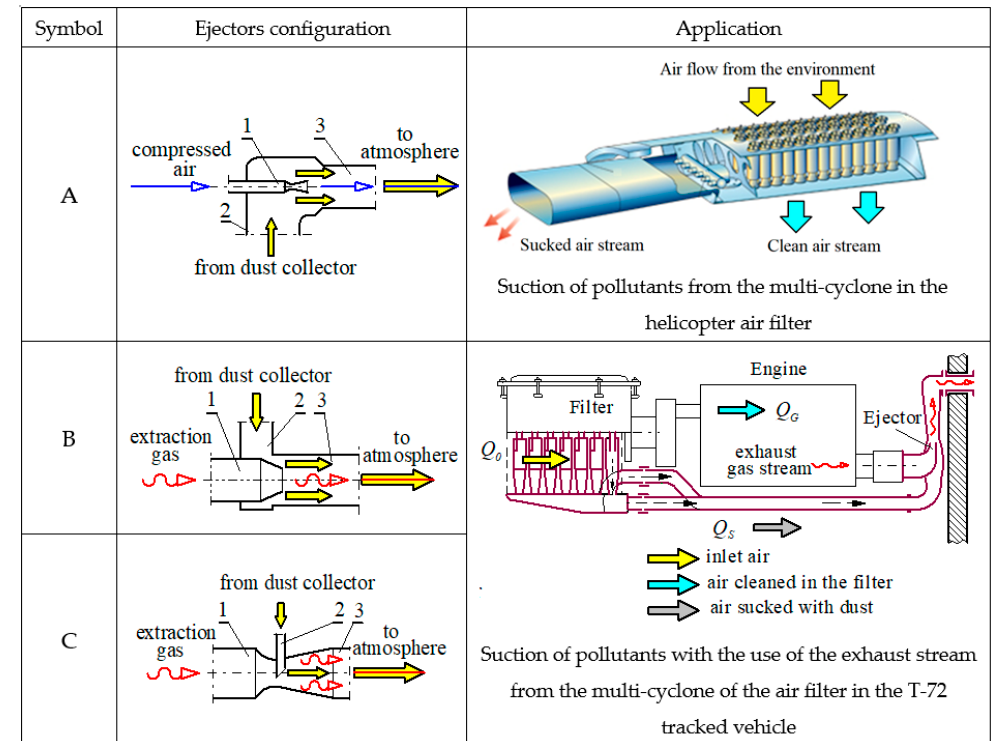
Figure 6. Ejector configurations used in suction systems to force an ejection stream: ( A )—compressed air [50], ( B , C )—exhaust gases: 1—active stream inlet duct, 2—passive stream inlet duct, 3—mixing chamber.